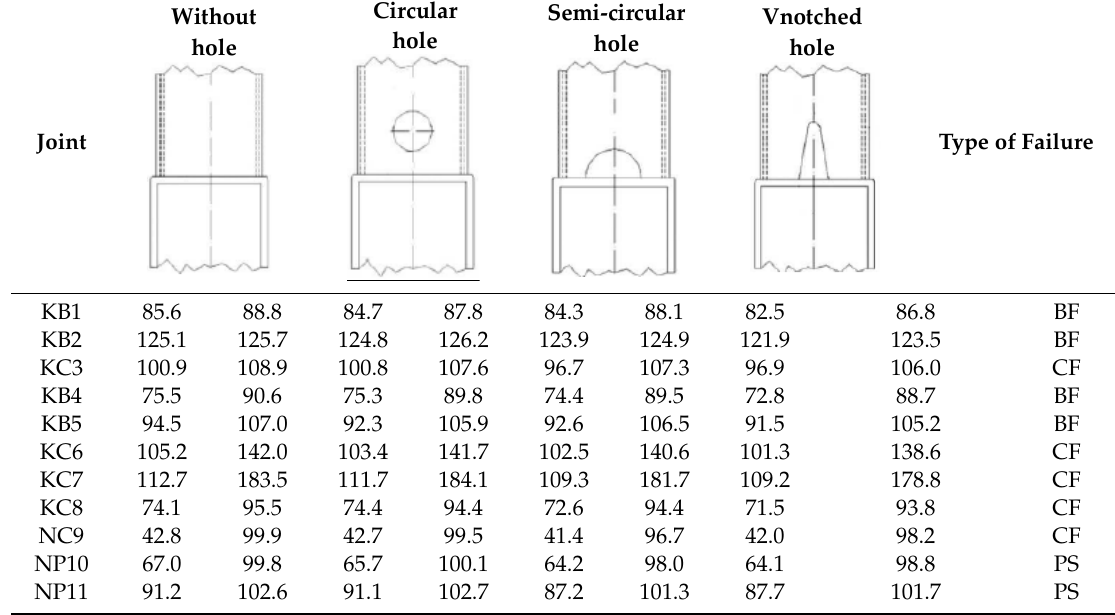
Table 5. Load for an indentation of 3%b 0 and maximum load in the joints [kN]. Circular Semi-circular Without Vnotched hole hole hole hole